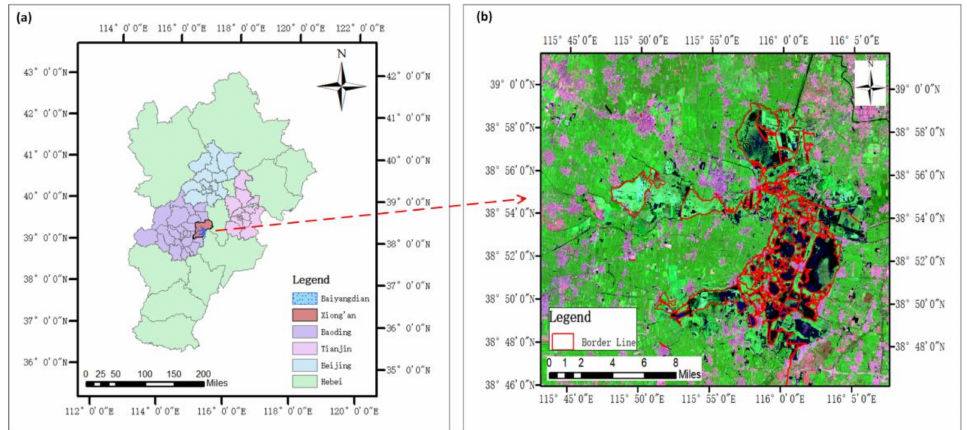
Figure 4. ( a ) The selected study area of case study one, the Baiyangdian Lake, located in the urban agglomeration of Beijing, Tianjin, and Hebei Provinces; ( b ) The Landsat 8 remote sensing imageries covering the Baiyangdian Lake, displayed by false color imageries using bands 7, 5, and 3 (Date: 18 September